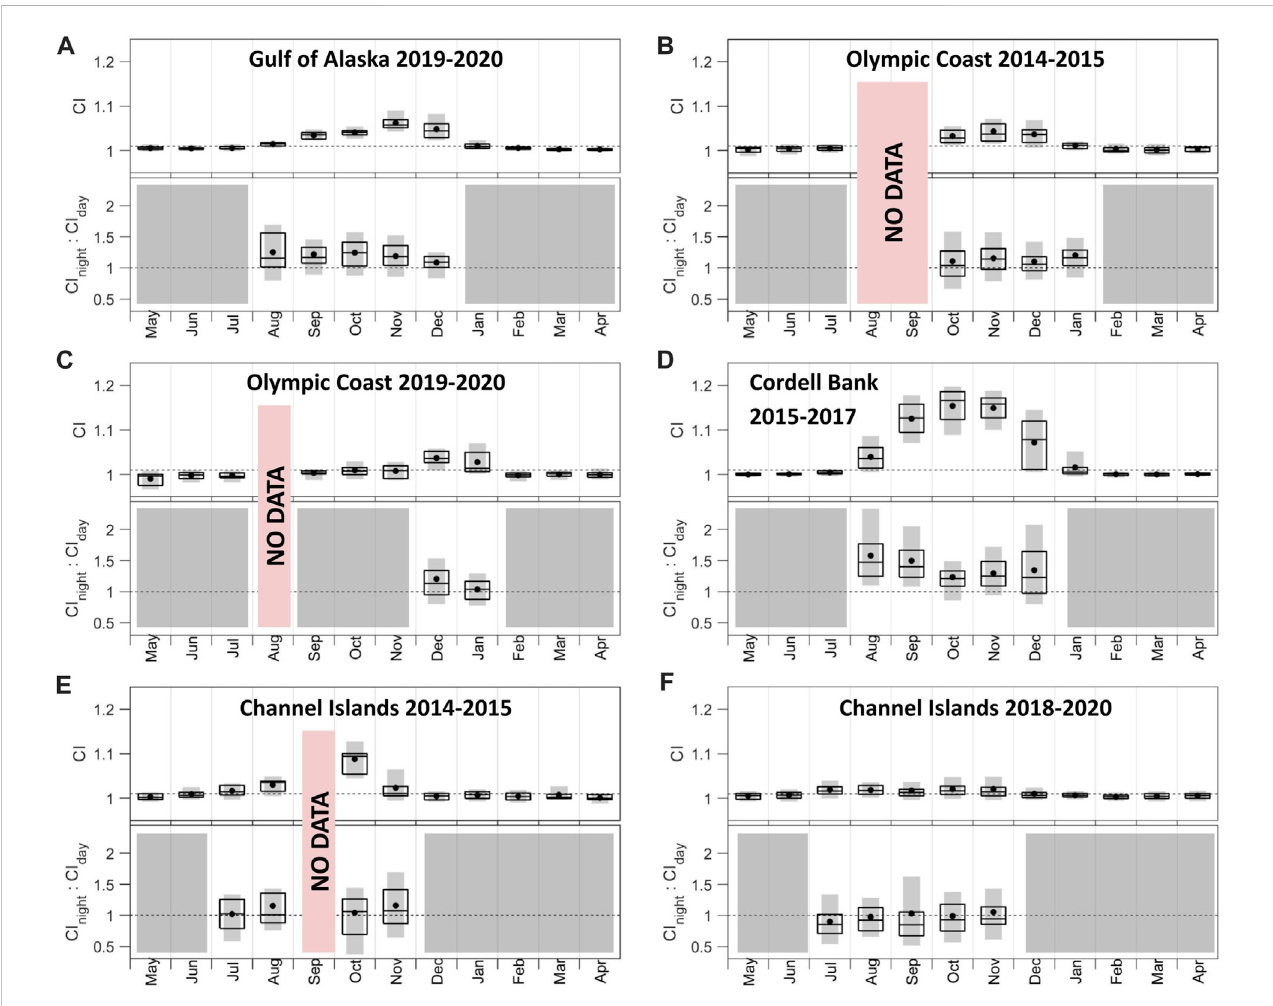
FIGURE 5 Callindex(CI)andCI night :CI day associatedwith bluewhaleBcallsacross (A) GulfofAlaska2019 – 2020, (B) OlympicCoast2014 – 2015, (C) OlympicCoast 2019 – 2020, (D) Cordell Bank 2015 – 2017, (E) Channel Islands 2014 – 2015, and (F) Channel Islands 2018 – 2020 sites. CI night :CI day values were only included if the monthly mean CI value was above 1.01. Months that did not meet this threshold are shown in gray. Periods of no data are noted in red. The dotted line in the top plots denotes the threshold for monthly mean CI (1.01). The dotted line in the bottom plots denotes the threshold for daytime song tendency (below than 1) and nighttime song tendency (greater than 1) calling. Boxplots show the 25th, 50th, and 75th percentiles of daily CI values from each month. Blackdotsindicatemeans.Graybarsindicate10th-90thpercentiles.Notethedatashownarenotnecessarilychronologically.SeealsoSupplementaryFigures S1,